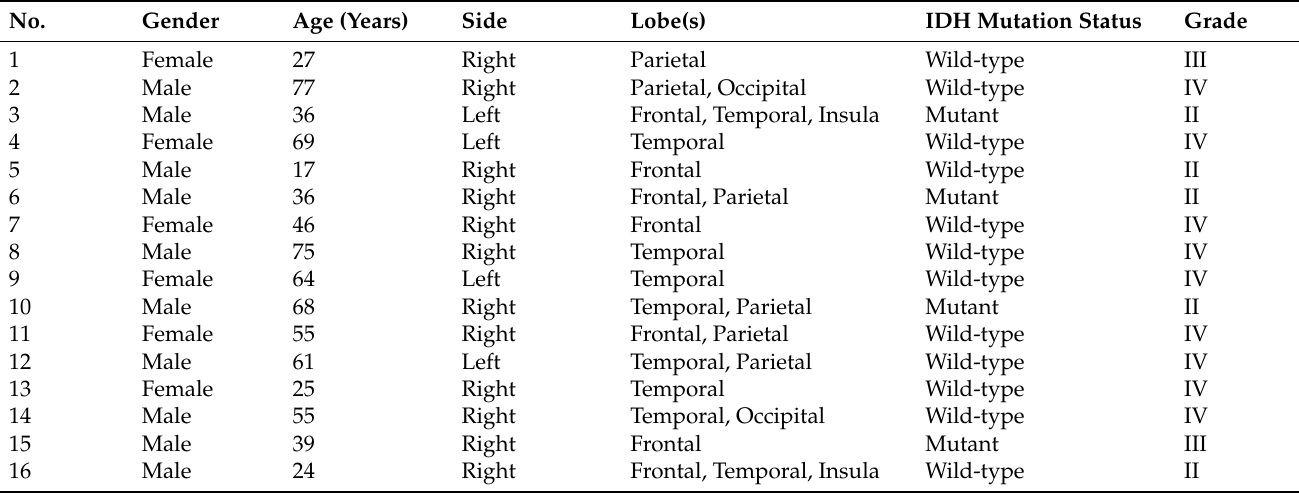
Table 1. Patient and tumor